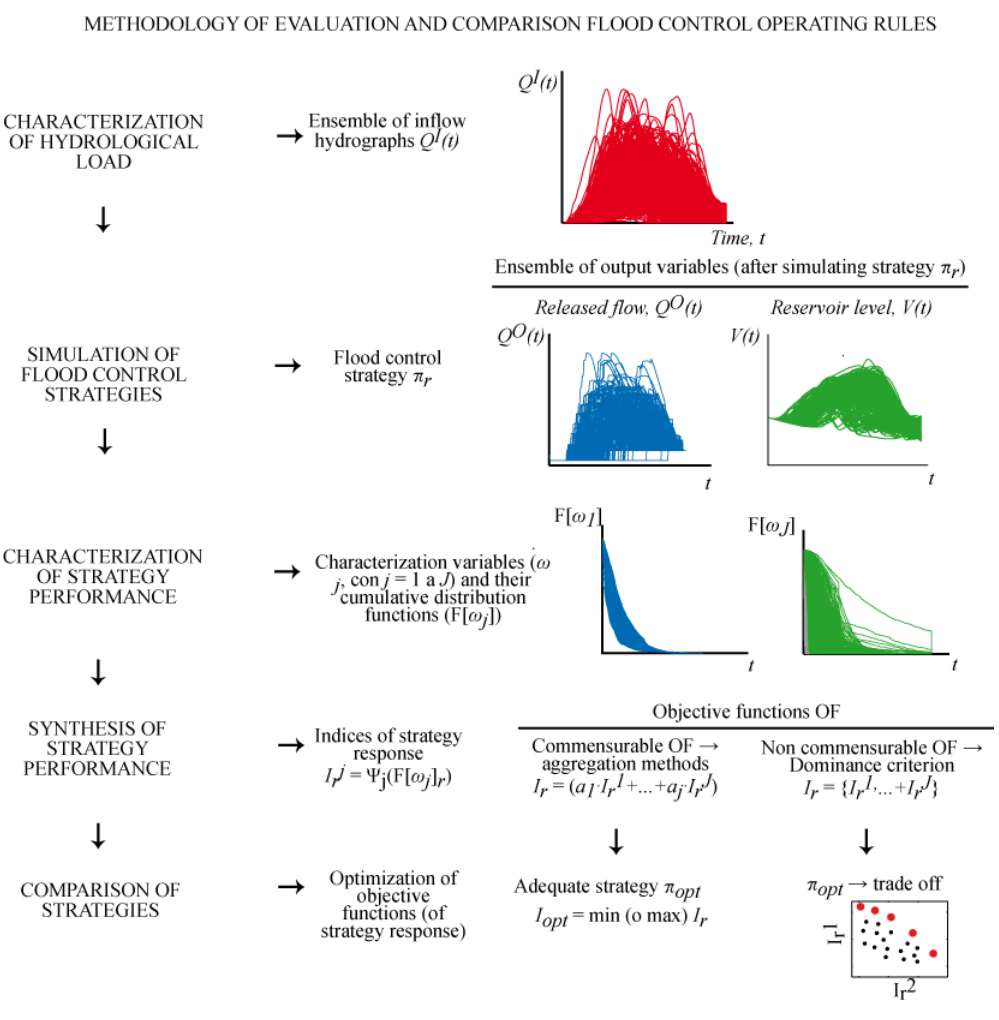
Figure 1. Conceptual